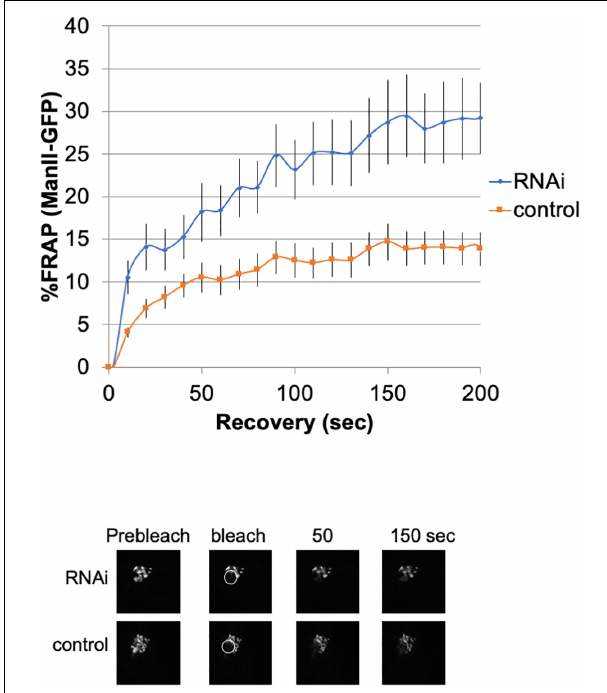
FIGURE 2 | Loss of Giantin changes the intra-connectivity between Golgi cisternae/stacks. HeLa cells stably expressing ManII-GFP with Giantin or control siRNA treatment were subjected to FRAP experiments. GFP-labeled Golgi in ManII-GFP expressing cells was photobleached, and fluorescence recoveries were monitored for 200 s and graphed ( n = 10, bar, SD). Representative images of fluorescence recovery at the indicated time points are shown below. Sizes 25.5 (w) × 25.5 (h) µ m. The circles represent the bleached area.